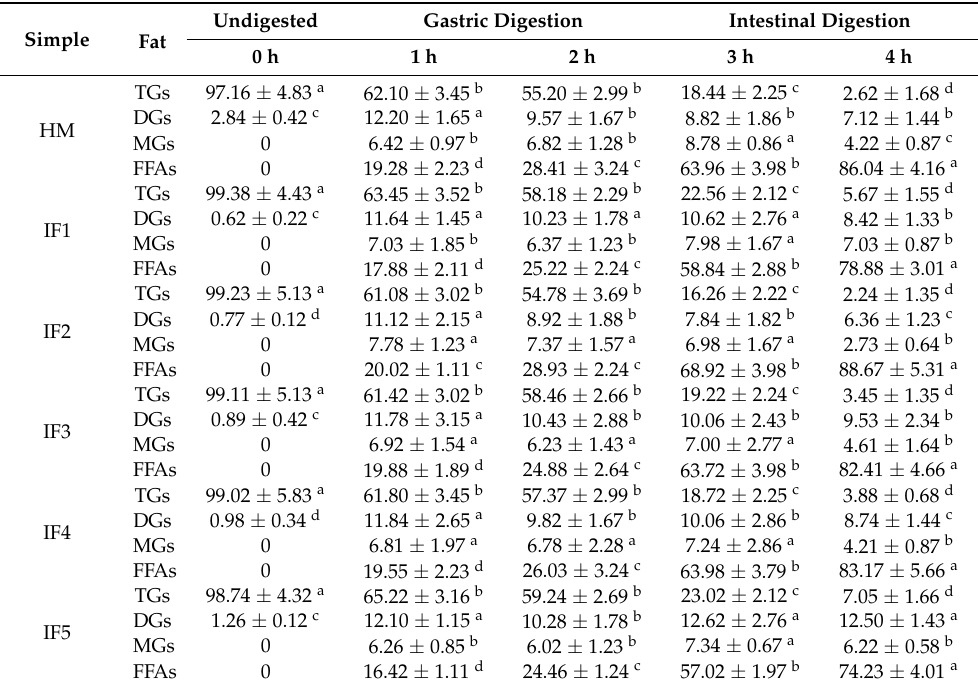
Table 2. Changes in the acylglycerol profile during the in vitro gastrointestinal lipolysis of human milk and infant